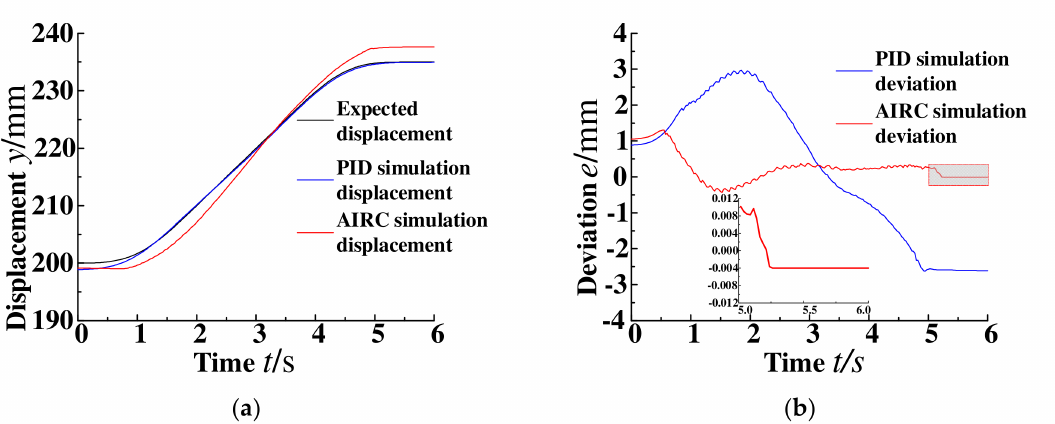
Figure 14. System displacement and deviation curve under working condition 4 (cid:13) . ( a ) System displacement curve. ( b ) System displacement deviation